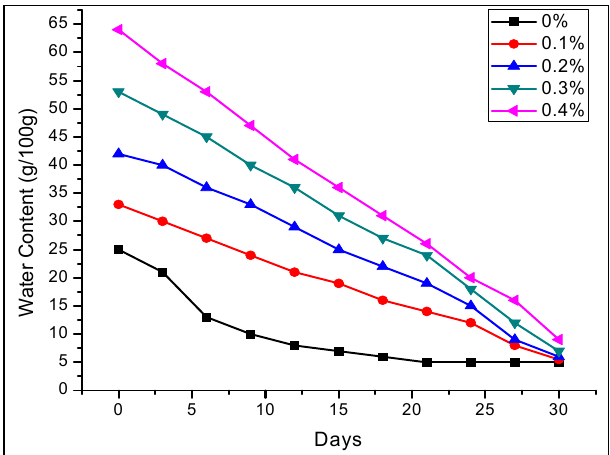
Figure 5. Water retention by the soil amended with different levels (0.1, 0.2, 0.3, 0.4 w/w%) of PHNC levels on water content at field